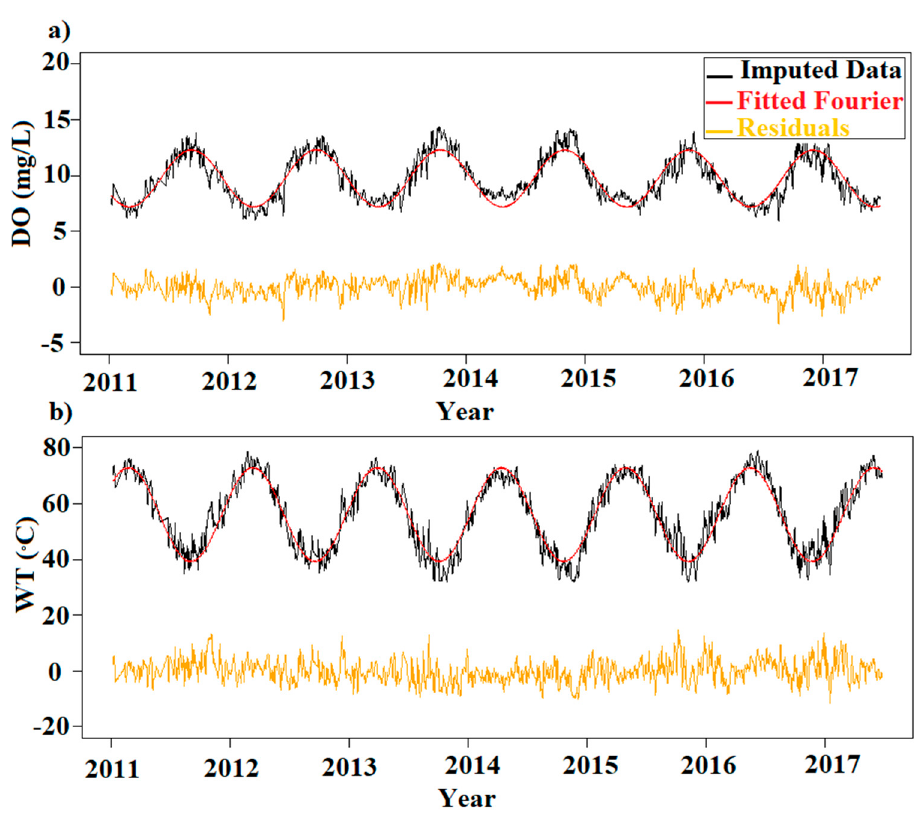
Figure 4. Time series, fitted Fourier series, and residuals (i.e., time series from which cyclic patterns are removed) for ( a ) DO and ( b ) water temperature.